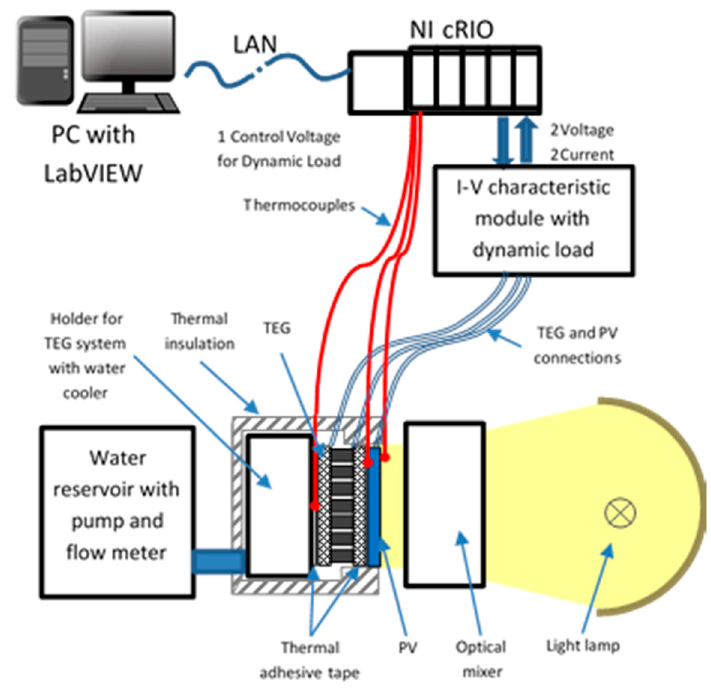
Figure 10. The experimental setup used for HS characterization under concentrated light [47].